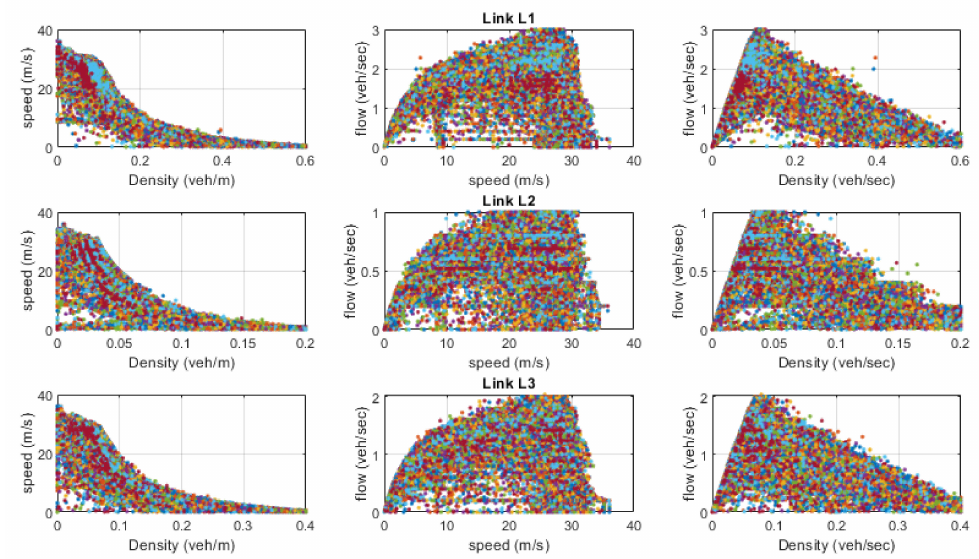
Figure 5. Speed, density, and flow plot of links in the network. The individual links are stitched together based on the connectivity matrix in Table 2. Each row (sub vector) in the matrix represents one link. The first, second, and third elements of a row denote link ID, start point, and end point, respectively. Node 1 or intersection 1 is the diverge point where traffic from link L1 diverges to links L2 and L3. Similarly, Node 2 is a merging point in the network where traffic from links L2 and L3 merges onto